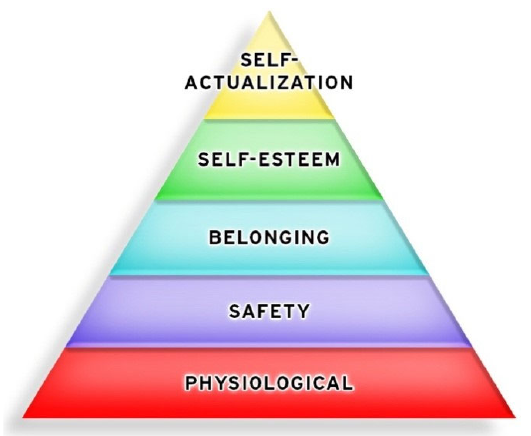
Figure 1. The misused pyramid of Maslow’s hierarchy of needs. This pyramid is often used in presentations, but is misinterpreted and over ‐ simplified as a rigid, linear process.